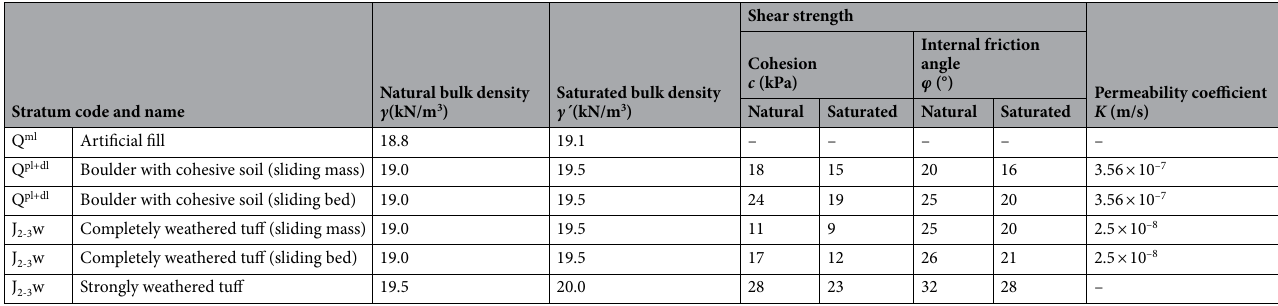
Table 2. Physical and mechanical parameters of rock and soil layer.